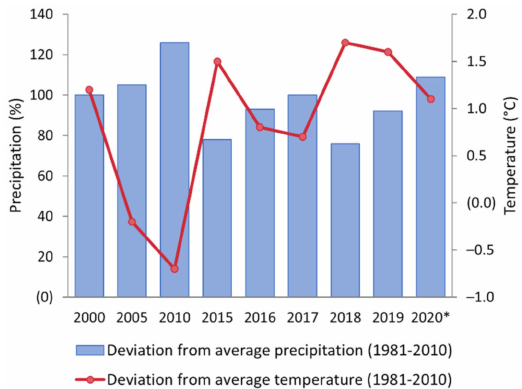
Figure 6. Deviations from the mean temperatures and precipitation (1981–2010) in the period